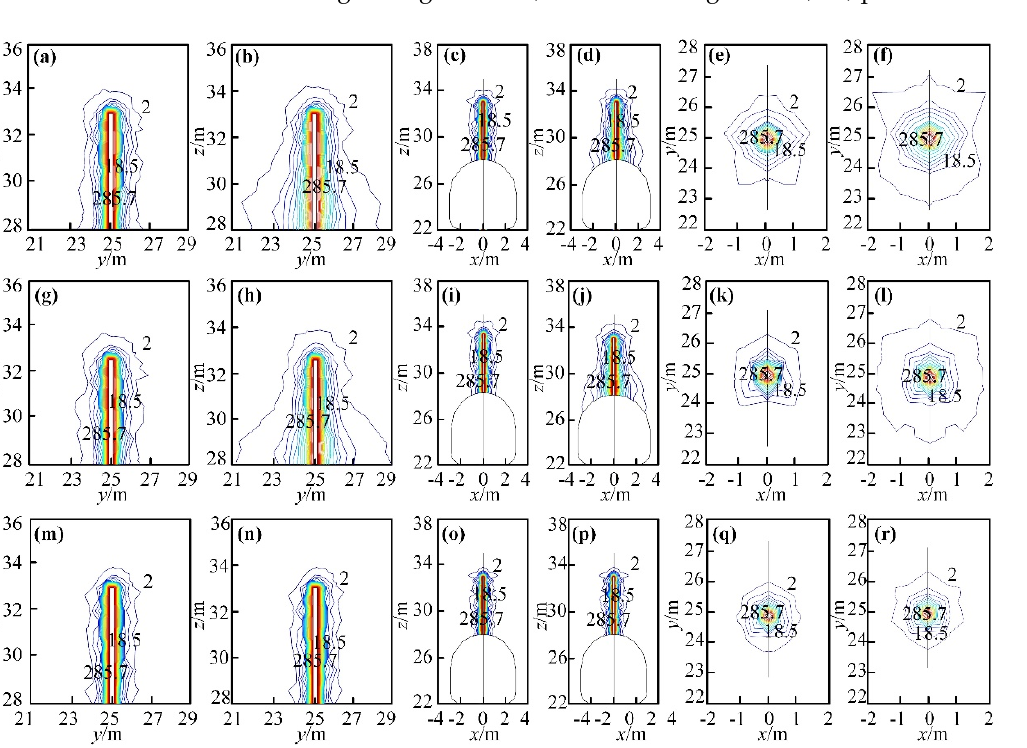
Figure 5. Spatial distribution characteristics of grout pressure head. ( a ) λ x = 1, λ y = 1; ( b ) λ x = 3, λ y = 3; ( c ) λ x = 1, λ y = 1; ( d ) λ x = 3, λ y = 3; ( e ) λ x = 1, λ y = 1; ( f ) λ x = 3, λ y = 3; ( g ) λ x = 1, λ y = 0.75; ( h ) λ x = 3, λ y = 0.75; ( i ) λ x = 1, λ y = 0.75; ( j ) λ x = 3, λ y = 0.75; ( k ) λ x = 1, λ y = 0.75; ( l ) λ x = 3, λ y = 0.75; ( m ) λ x = 0.75, λ y = 1; ( n ) λ x = 0.75, λ y = 3; ( o ) λ x = 0.75, λ y = 1; ( p ) λ x = 0.75, λ